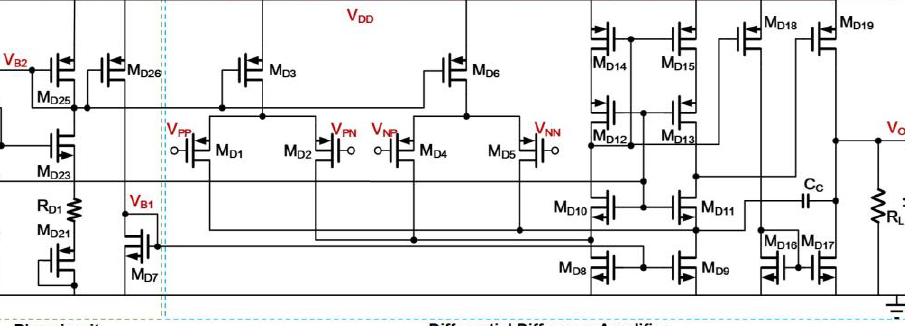
Figure 12. Schematic of the DDA. Table 3. Power allocation in proposed and conventional enhancer with 1.2 V supply voltage.